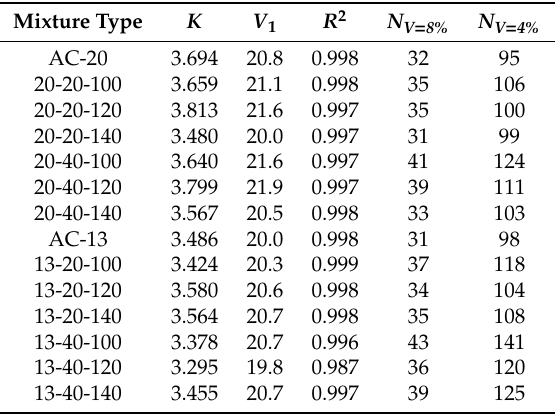
Table 7. Regression results of Equation (6) and